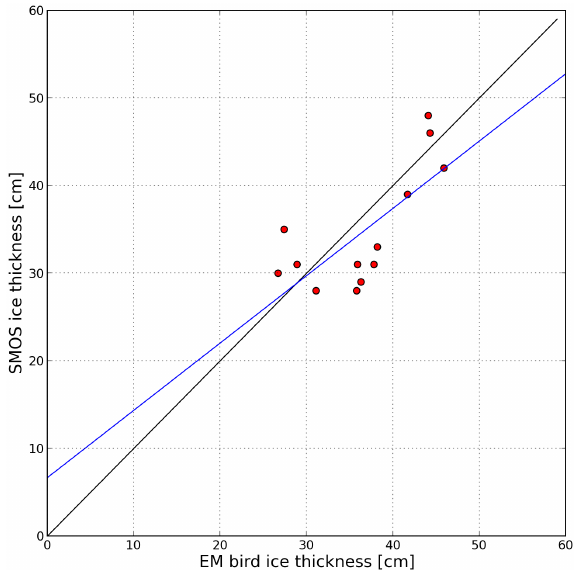
Fig. 9. Scatter plot of EM bird versus SMOS SIT retrieval. Blue: regression line. RMSD between data and regression line: 5cm, cor- relation of r = 0 .